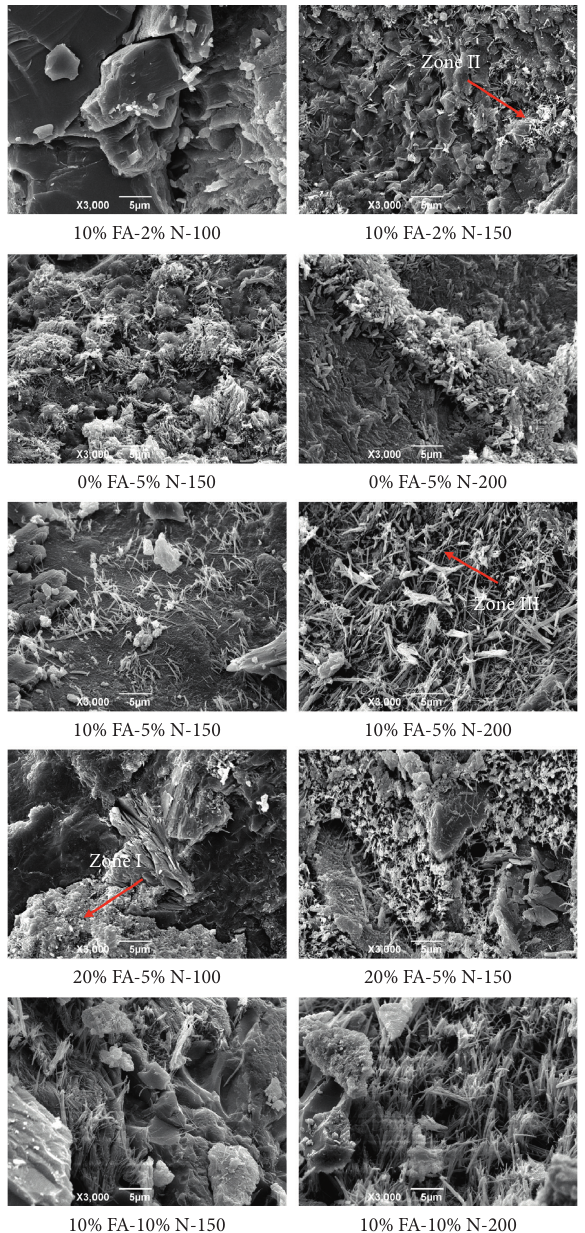
Figure 6: SEM images of the concrete specimen (FA-fly ash and N- Na 2 SO 4 solution).